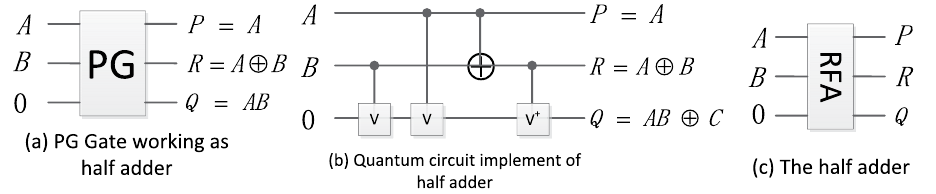
Figure 12. The half-adder and its quantum circuit.